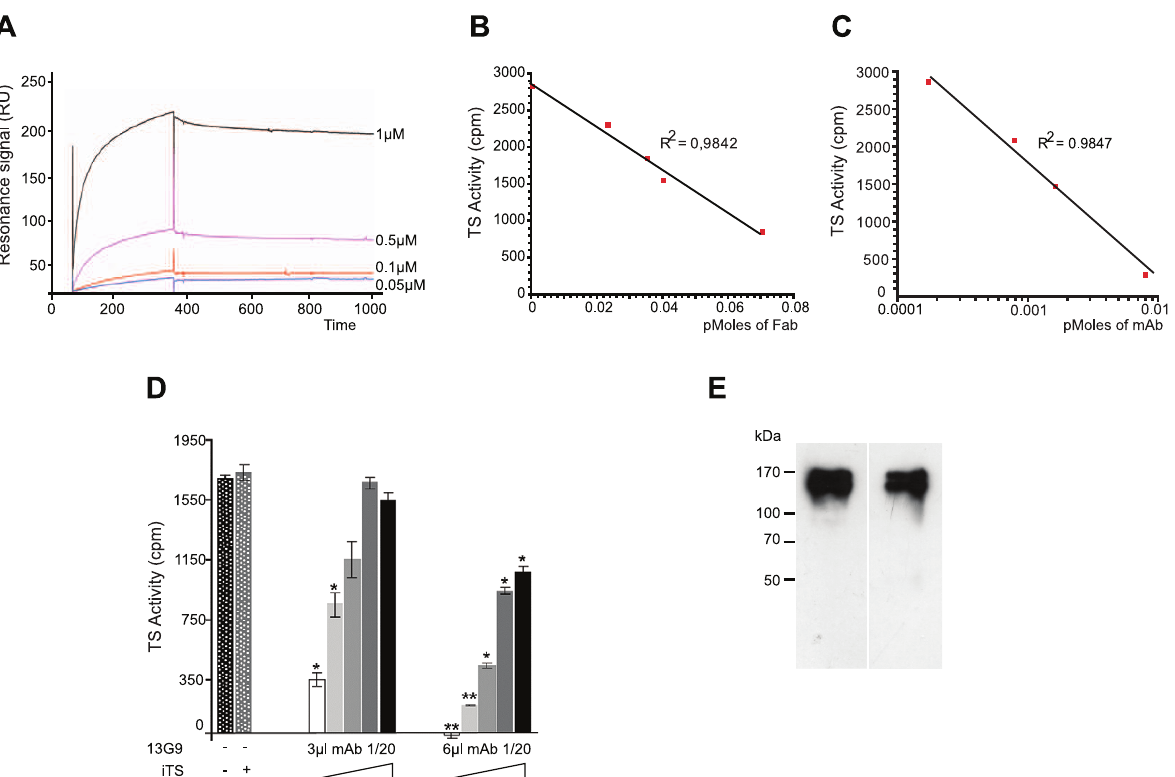
Figure 1. Biochemical characterization of the TS-13G9 mAb interaction. A ) Surface plasmon resonance analysis of TS-mAb 13G9 interaction kinetics. mAb 13G9 was immobilized onto a CM5 sensor chip and the indicated concentrations of TS were injected in the mobile phase. B, C ) mAb 13G9 inhibition of TS activity. TS (2 ng) was mixed with increasing amounts of purified Fab ( B ), or whole 13G9 IgG ( C ) and remnant TS activity was assayed. D ) Competition assay for mAb 13G9-TS binding. TS activity was assayed (2 ng, 30 min) in the presence of the neutralizing mAb (3 and 6 m l of hybridoma culture supernatant diluted 1/20) and increasing amounts (from 0 to 8 ng) of the inactive TS (iTS) were added. Student’s t test was used. * p , 0.05; ** p , 0.005 comparing against TS activity without mAb addition E ) Specificity of the mAb 13G9. Trypomastigotes were biotinylated, washed and mAb 13G9 added to pull-down reacting proteins. Western blots were developed with anti-SAPA (left) and streptavidin (right).